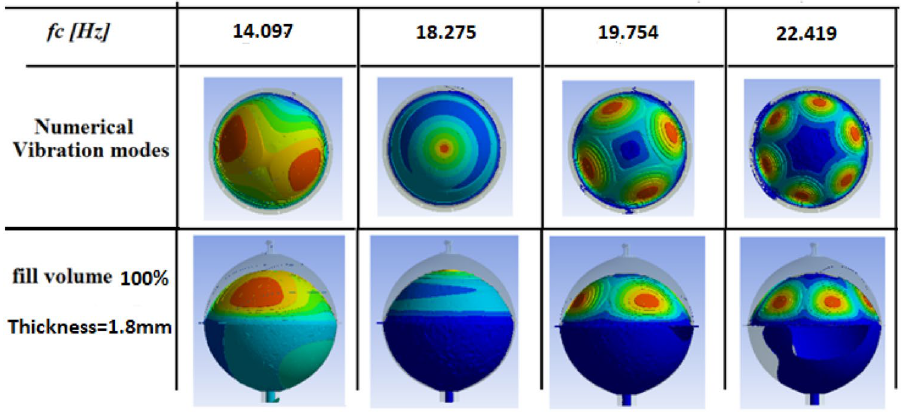
Table 7 Frequency analysis result of diaphragm tank